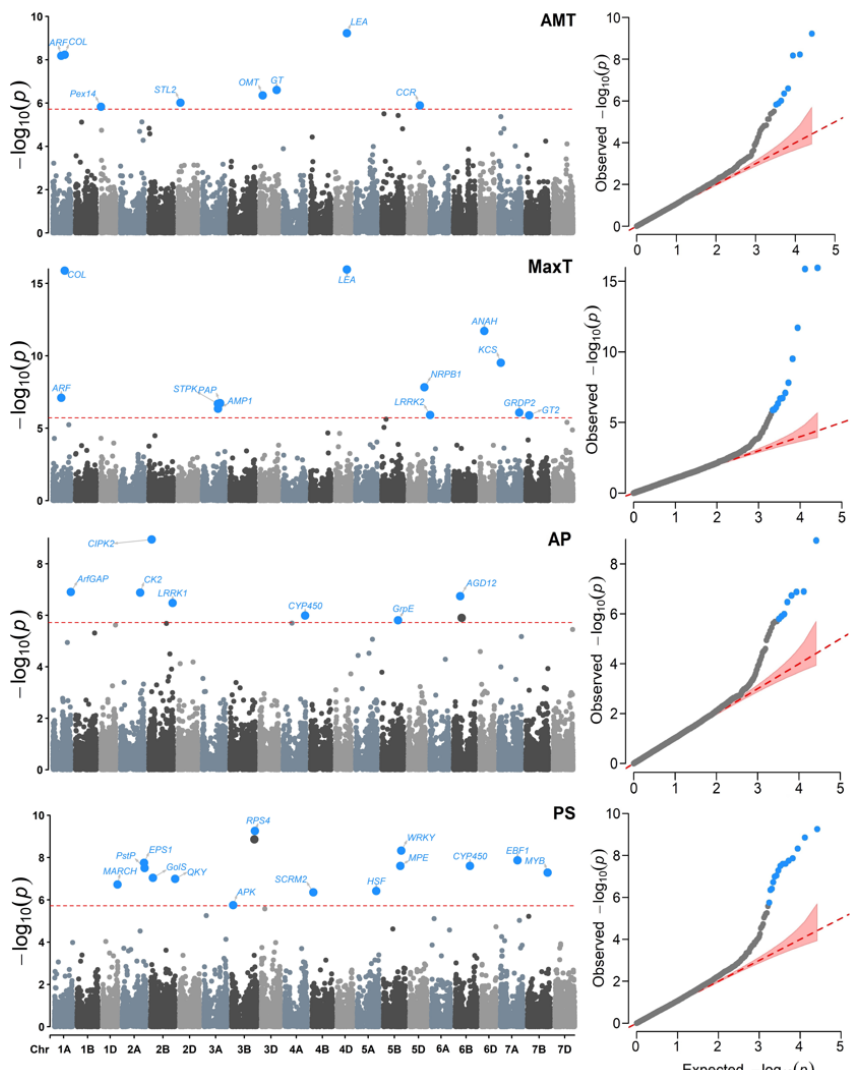
Figure 4. Manhattan ( left ) and QQ ( right ) plots for the Genome–environment Associations (GEA) analyses with the FarmCPU model and the variables: annual mean temperature (AMT), maximum temperature (MaxT), annual precipitation (AP), and precipitation seasonality (PS) in 990 landraces of bread wheat and 26,064 SNP markers. The red dashed horizontal line marks the -log 10 ( p- value) threshold after Bonferroni correction for multiple comparisons. The proteins associated with the significant SNPs are labeled in each graph.